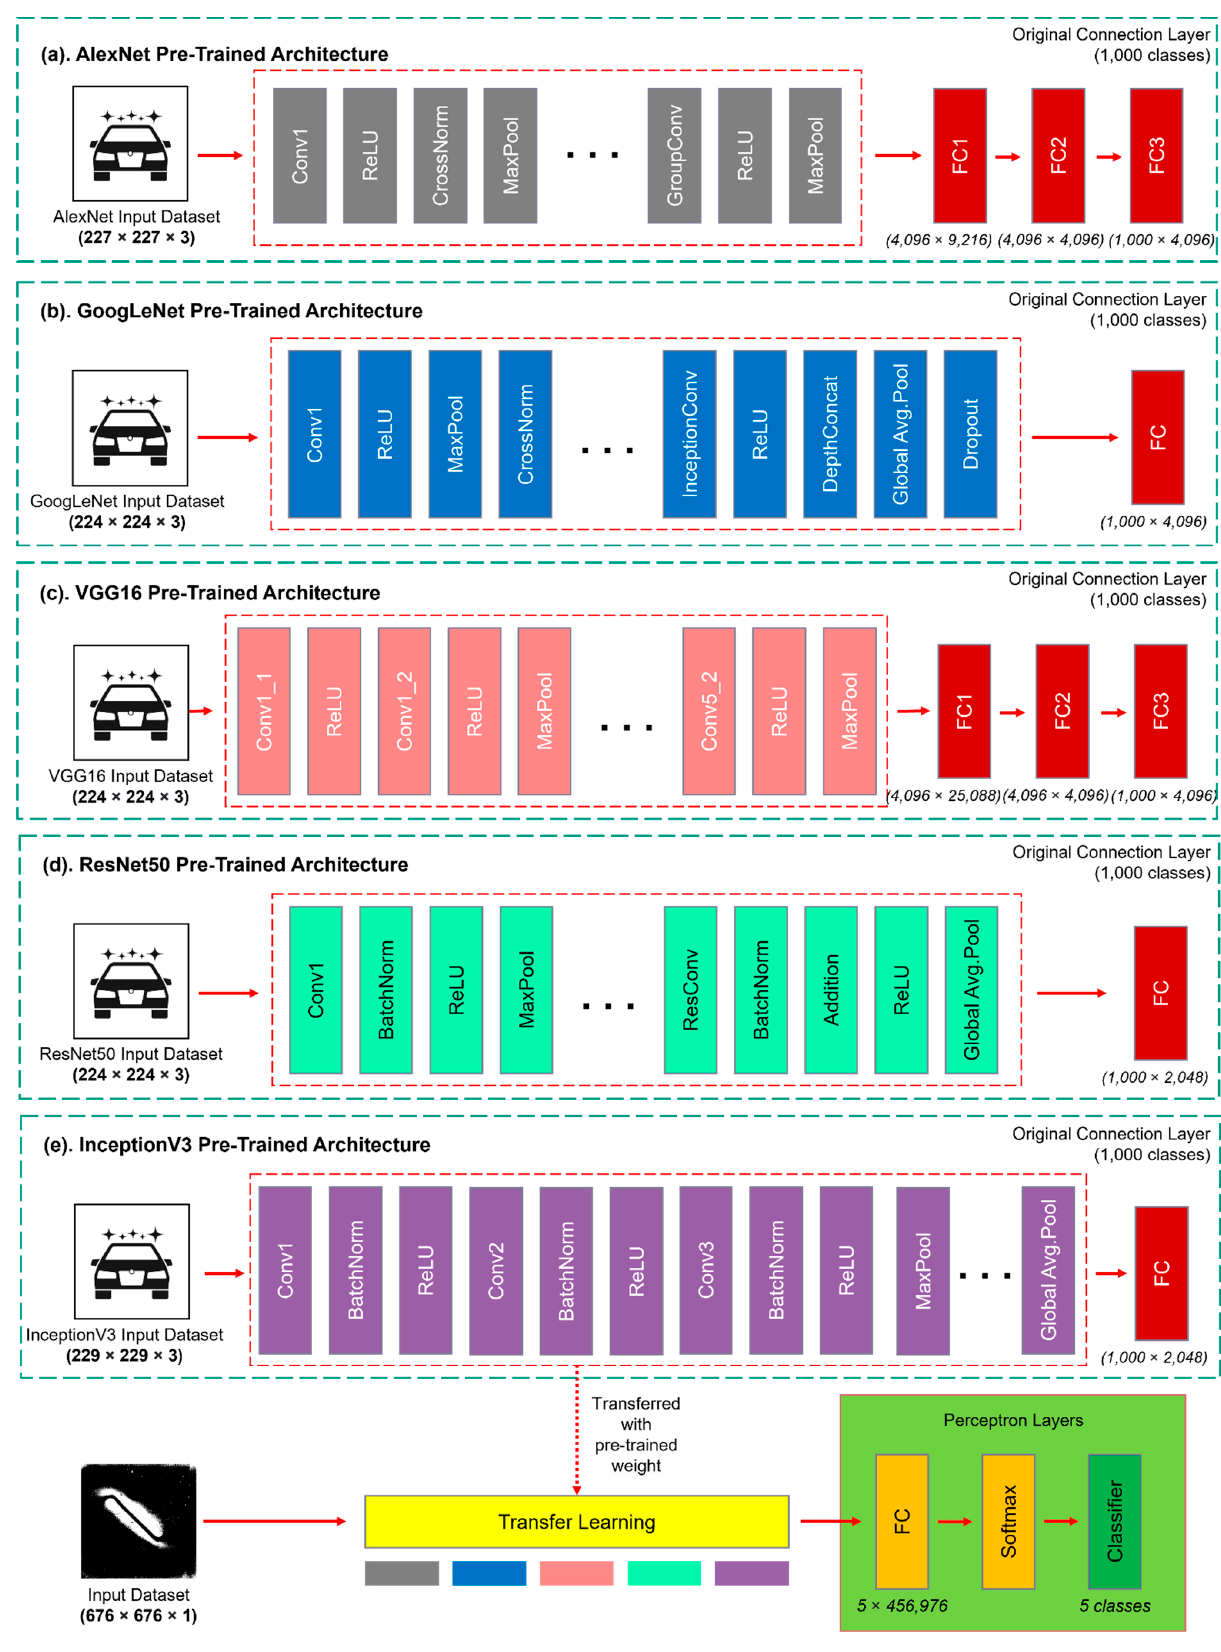
Figure 6. Transfer learning of five pretrained architectures using MONDI dataset.